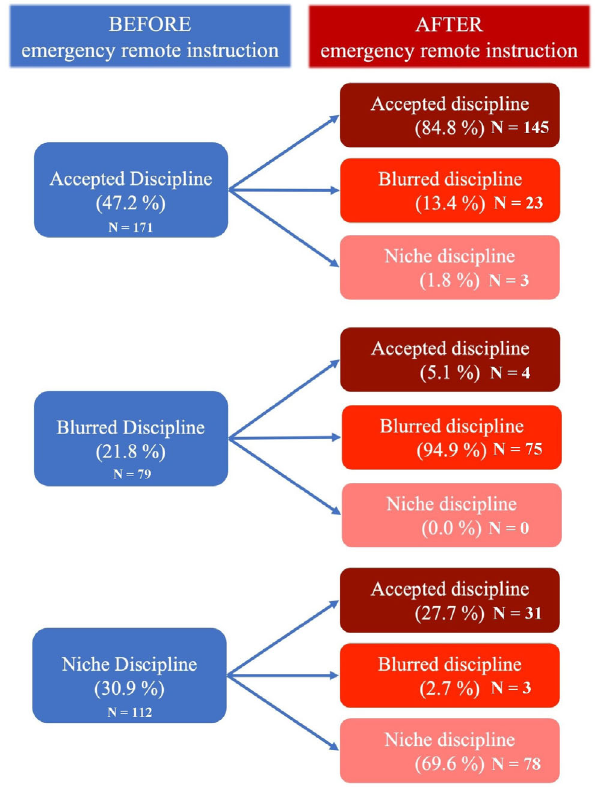
FIG. 7. Changes in attitudes toward physics before and after the emergency remote